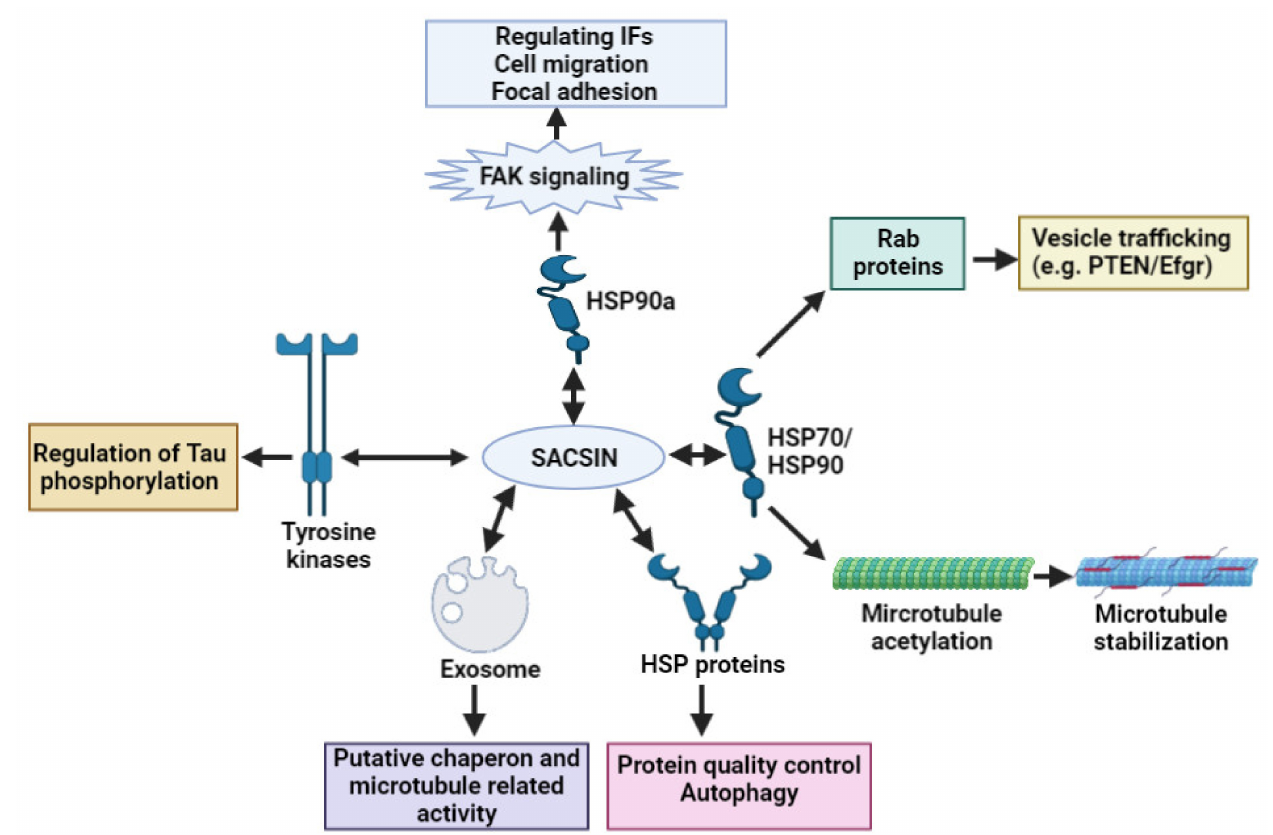
Figure 2. Possible impact of sacsin in different cellular processes, including chaperon functions, microtubule organization and vesicle